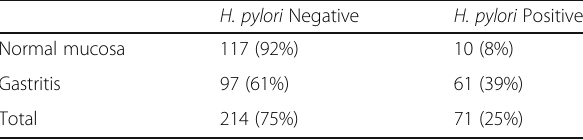
Table 1 Association between the presence of H. pylori and changes in the gastric mucosa